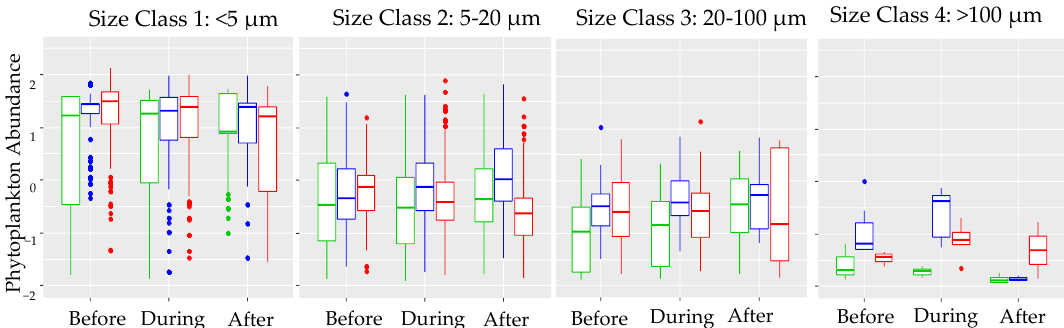
Figure 7. Size class distributions of HN (based on abundance data (individual mL − 1 ), applying Box-Cox transformation) among the treatments before, during, and after the HW. Scales are identical for all plots.